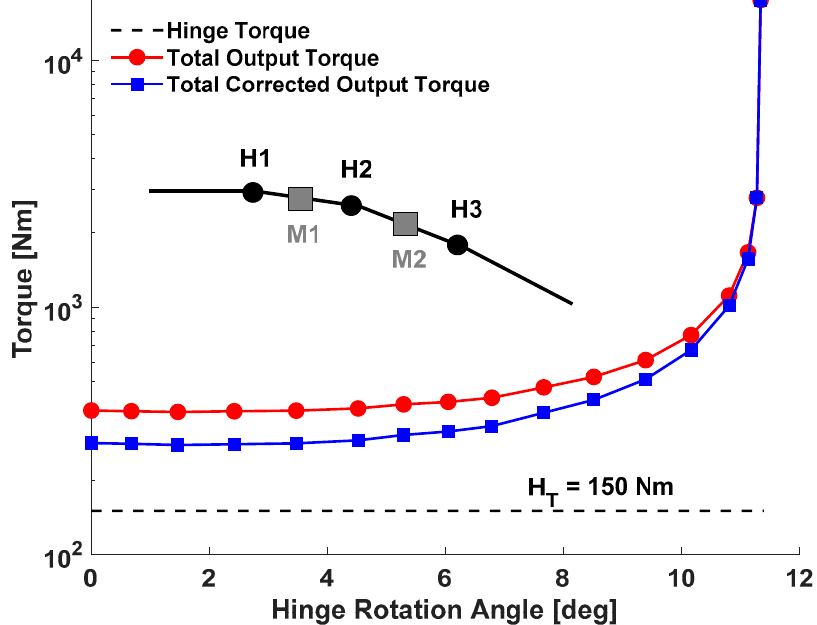
Figure 9. Actuation total output and H3 hinge torque trends vs. H3 hinge rotation angle.